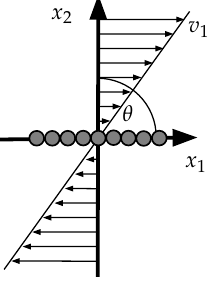
Figure 2. A fiber is placed horizontally with φ = π /2 in a shear flow. The top and bottom walls have a prescribed velocity and a no-slip condition, the boundary conditions in x 1 direction are